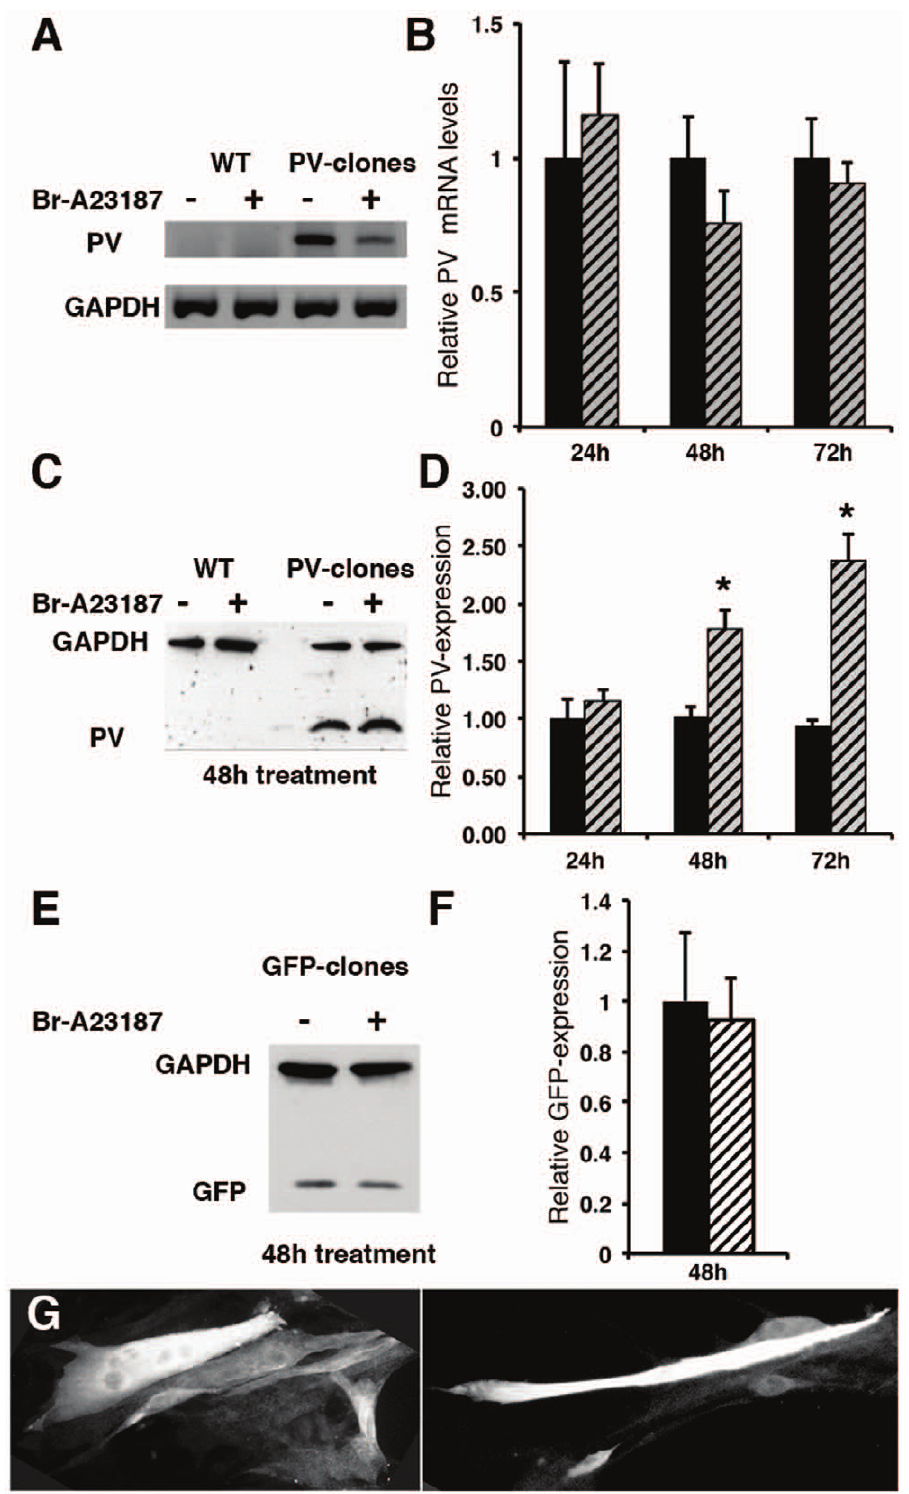
Figure 1. Effect of mild ionophore treatment on PV expression levels in PV-transfected C2C12 cells. A) Detection of mRNA for PV and GAPDH (for normalization) in control (WT) and PV-transfected myotubes by RT-PCR. No signal was detected in WT myotubes before and after ionophore treatment. B) Ionophore treatment did not significantly affect PV mRNA levels (striped bars) of PV-clones at 24–72 h after treatment in comparison to untreated cells (black bars). C) Protein expression levels of PV and GAPDH in WT and PV-clones subjected to Ca 2 + ionophore treatment (1 m M Br-A23187 for 48 h ( + ) or untreated cells ( 2 ) determined by Western blot analysis. D) Semi-quantitative analysis of PV Western blot signals in C2C12 PV-clones exposed to Br-A23187 for 24–72 h (striped bars) in comparison to untreated cells (black bars). A significant increase in PV expression levels was observed at 48 and 72 h (*; p , 0.05; n=8 values at each time point). E–F: Relative GFP protein expression in GFP-positive C2C12 clones in